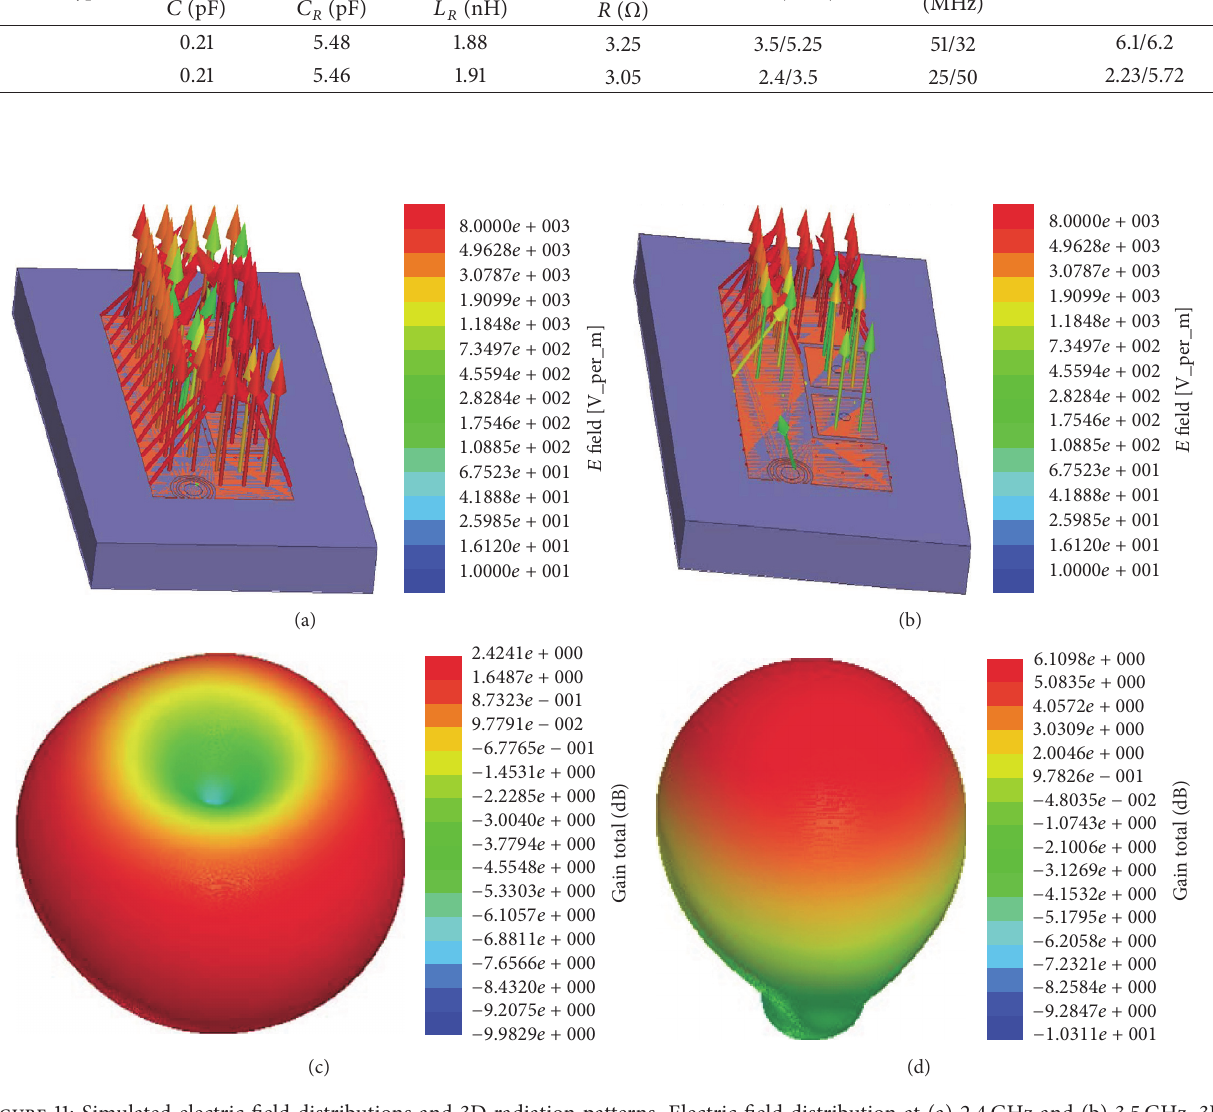
Figure 11: Simulated electric field distributions and 3D radiation patterns. Electric field distribution at (a) 2.4 GHz and (b) 3.5 GHz. 3D radiation patterns at (a) 2.4 GHz and (b) 3.5